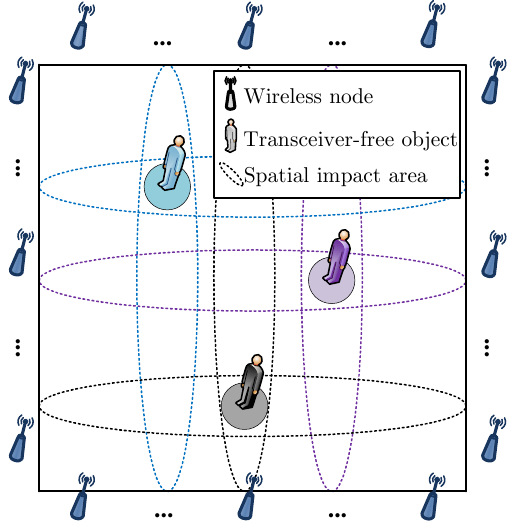
Figure 1. An example of the CS-based